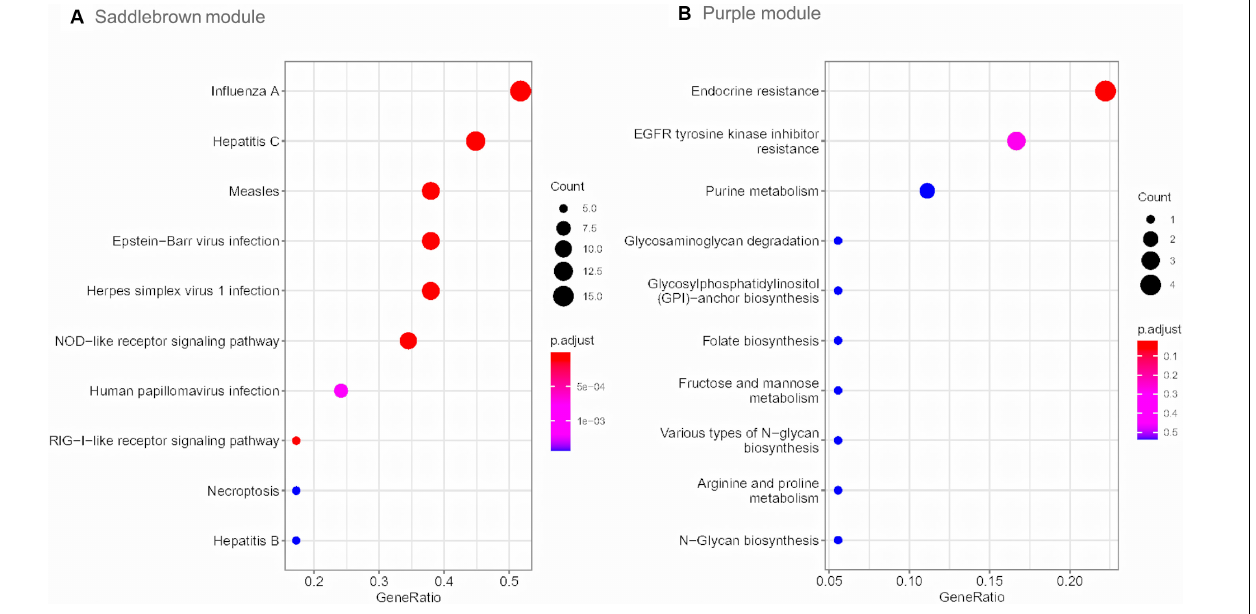
FIGURE 4 | KEGG pathway enrichment analysis. The size of each circle means the amounts of genes. The different color of each circle means the P -value. RichFactor means the number of genes in the key module that belong to this pathway divided by the number of genes in the background gene cluster that belong to this pathway. The top 10 KEGG enrichment pathways of genes in saddlebrown (A) and purple module (B) . KEGG, Kyoto Encyclopedia of Genes and